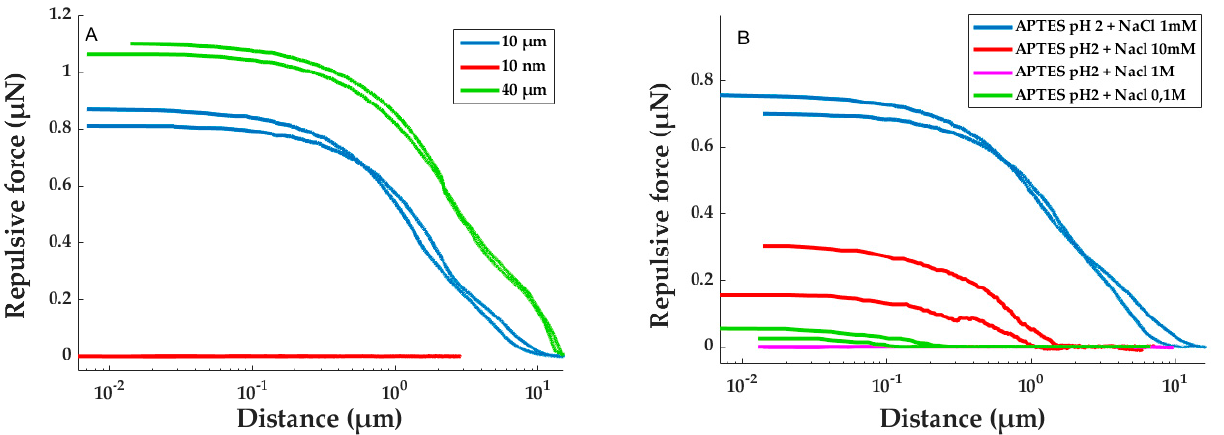
Figure 1. AFM force–distance curves at pH 2 between two APTES surfaces (one flat surface and one spherical, glued on the tipless cantilever): ( A ) influence of the functionalized borosilicate sphere: 10 nm (red), 10 µm (blue), and 40 µm (green); ( B ) in fl uence of the ionic strength for a 10µm borosilicate sphere diameter glued on the tipless: no salt added (blue), 10 mM (red), 0.1 M (green), and 1 M (pink). All the surfaces were functionalized by APTES.